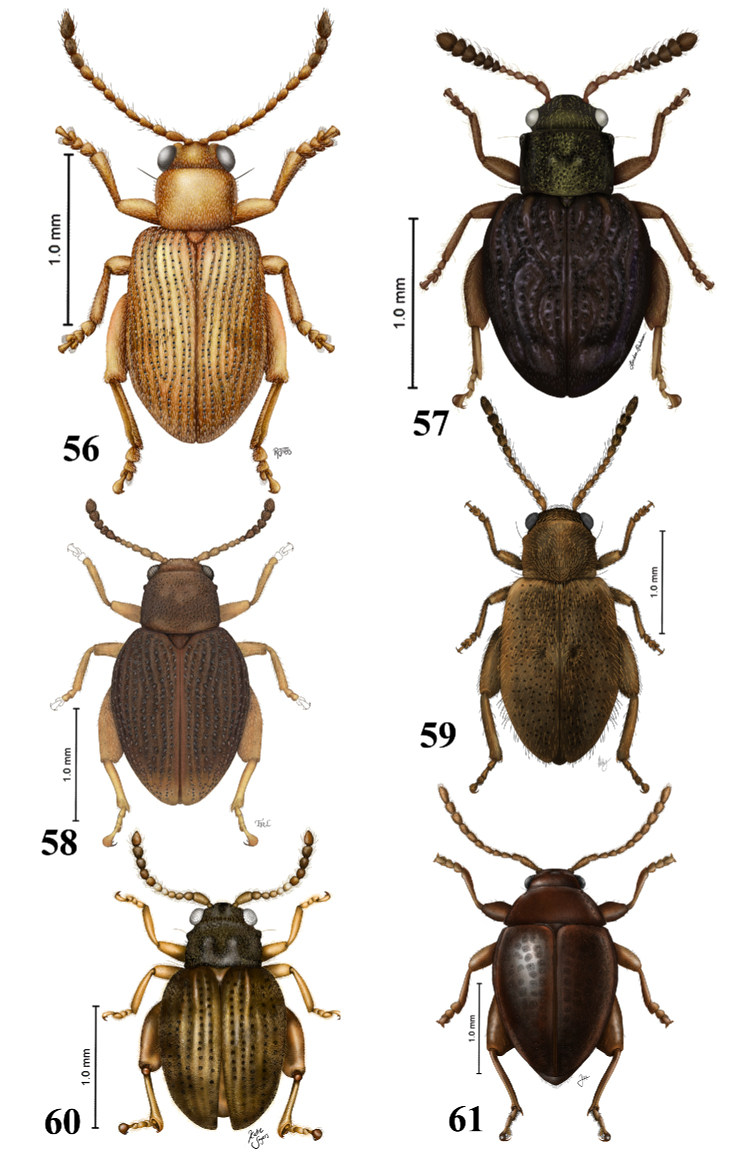
Habitus drawing of moss inhabiting Monoplatina. 56Aedmonsericellum Clark (illustration by Rebecca Jabs, National Museum of Natural History and Systematic Entomology Laboratory scientific illustrator internship program, summer 2016) 57Andersonalticavillabarrancoli Konstantinov & Linzmeier (illustration by Linden Pederson, National Museum of Natural History and Systematic Entomology Laboratory scientific illustrator internship program, summer 2019) 58Apleuralticacurculionoides Bechyne (illustration by Taina Litwak Systematic Entomology Laboratory) 59Distigmopteraborealis Blake (illustration by Abby Williams, National Museum of Natural History and Systematic Entomology Laboratory scientific illustrator internship program, summer 2016) 60Menudosmaricao Linzmeier & Konstantinov (illustration by Katie Sayers, National Museum of Natural History and Systematic Entomology Laboratory scientific illustrator internship program, summer 2019) 61Ulricaeltoro Konstantinov & Konstantinova (illustration by Jessica Hsiung, National Museum of Natural History and Systematic Entomology Laboratory scientific illustrator internship program, summer 2013).